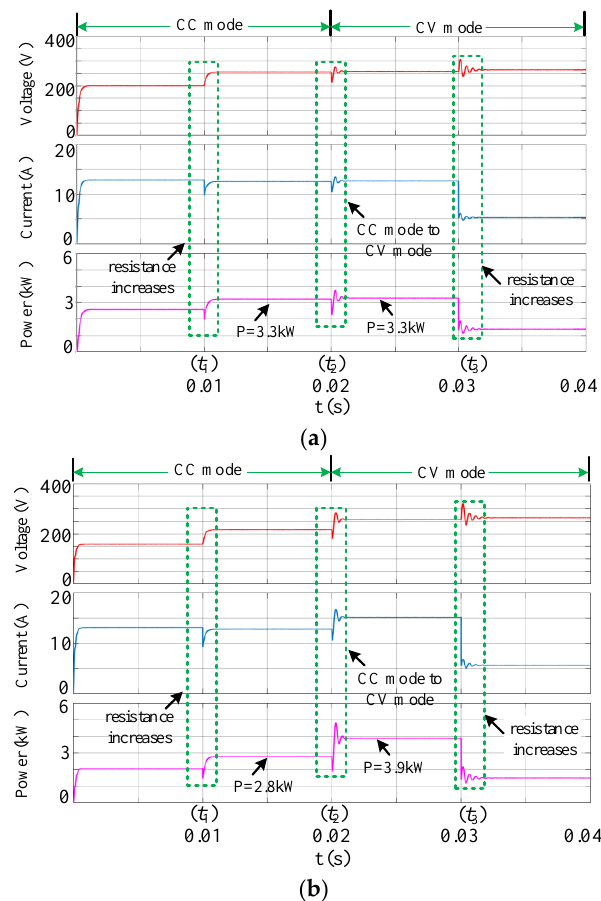
Figure 11. Charging process under t 1 : Increasing the resistance. t 2 : Switching from CC mode to CV mode. t 3 : Increasing the resistance. ( a ) Constant rated output power during switching. ( b ) Changing rated output power during switching.